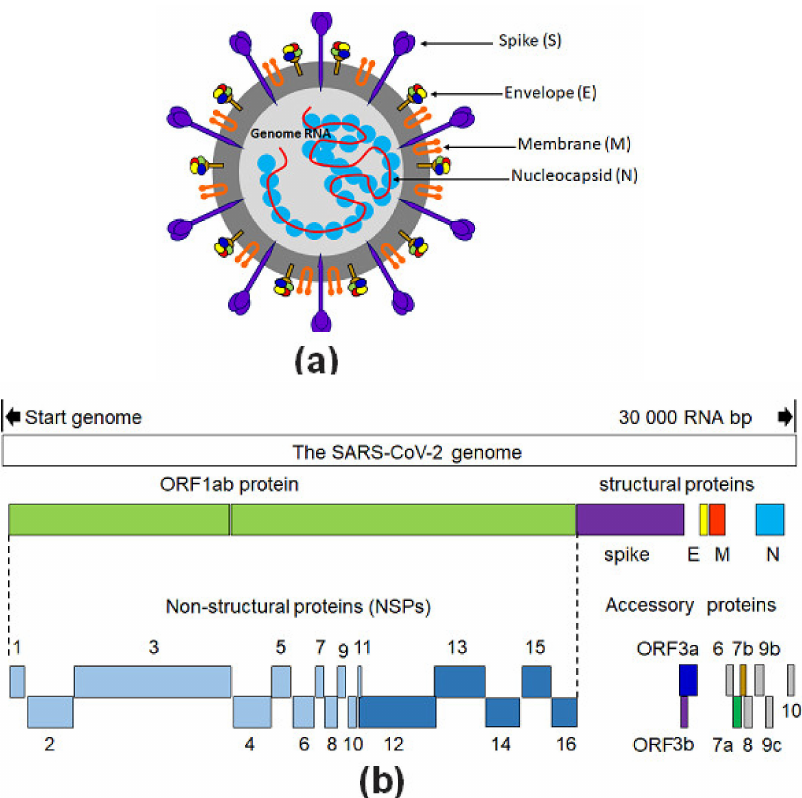
Figure 1. SARS-CoV-2 structure representation. ( a ) Schematic model for location of the main surface proteins of the new coronavirus. ( b ) Genome structure organization of open reading frames (ORFs) for structural, accessory, and non-structural proteins and their relative genome